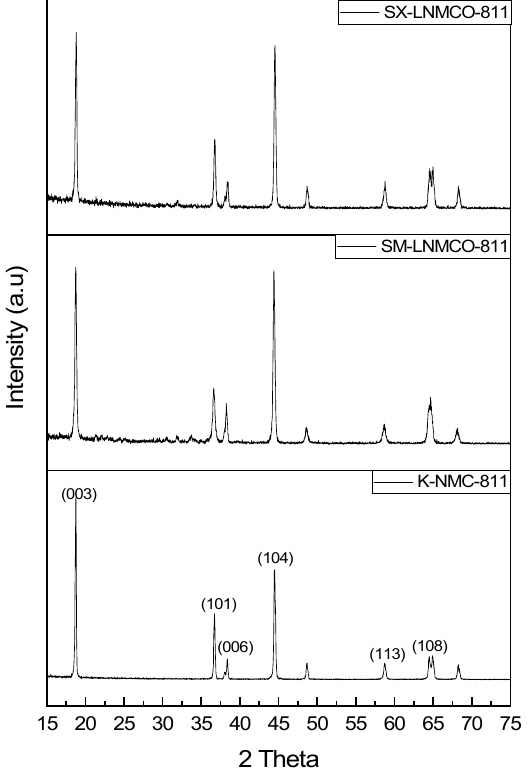
Figure 3. The X ‐ ray diffraction patterns of SM ‐ LNMCO ‐ 811, SX ‐ LNMCO ‐ 811, and K ‐ NMC ‐ 811. Figure 3. The X-ray diffraction patterns of SM-LNMCO-811, SX-LNMCO-811, and